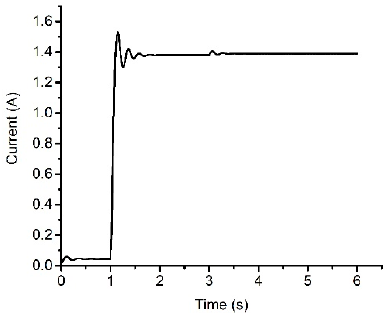
Figure 11. Current Response of EHPAAPP with backstepping sliding control method in the case of input signal change from 28 MPa to 24 MPa with flow